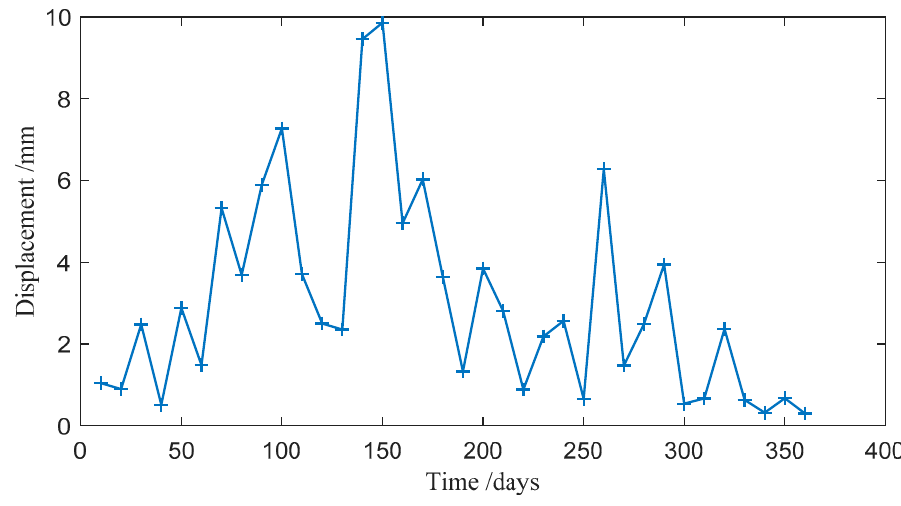
Figure 6. Displacement-time curve of the Dashuitian landslide.